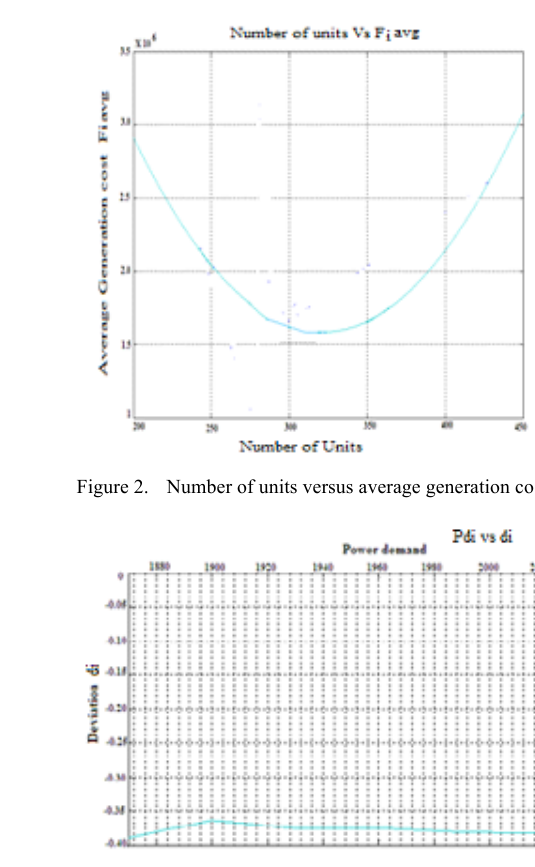
Figure 1. Variation of real power of Solar power plant versus Cost of generation of thermal power plant